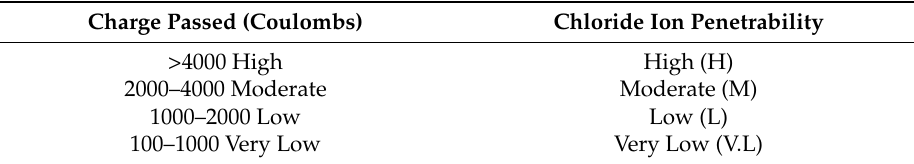
Figure 29. Concrete specimens and test set up (ASTM C1202). Table 8. RCPT ratings (per ASTM C1202).